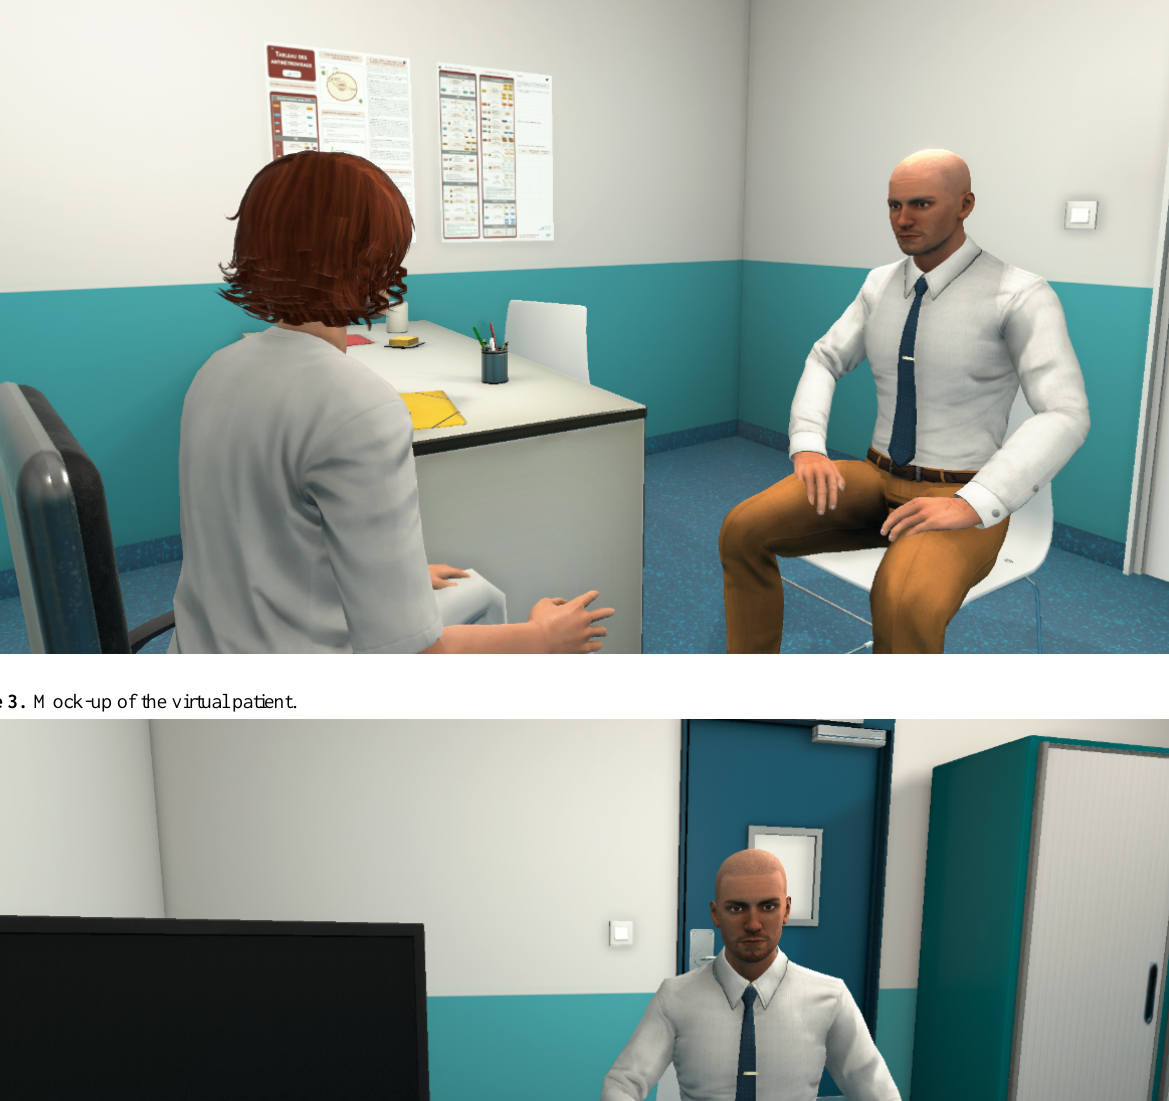
Figure 2. Mock-up of the virtual office including nurse and patient.